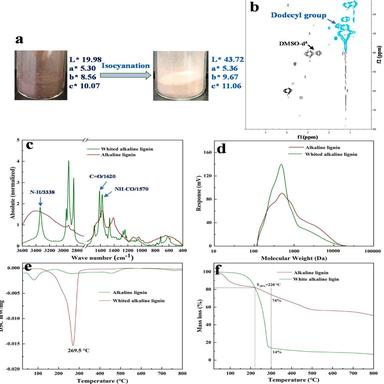
Preparation and characterization of the white lignin from alkaline lignin. (a) White lignin material preparation from alkaline lignin and the determined values of CIE Lab color space are presented; (b) 2 D NMR analysis findings for the white lignin, in which the dodecyl group was detected. (c) FTIR analysis of raw alkaline lignin and white lignin, the emerging peaks in the whited lignin are identified; (d), (e), (f) GPC, TG, DSC analysis of alkaline lignin and white lignin.